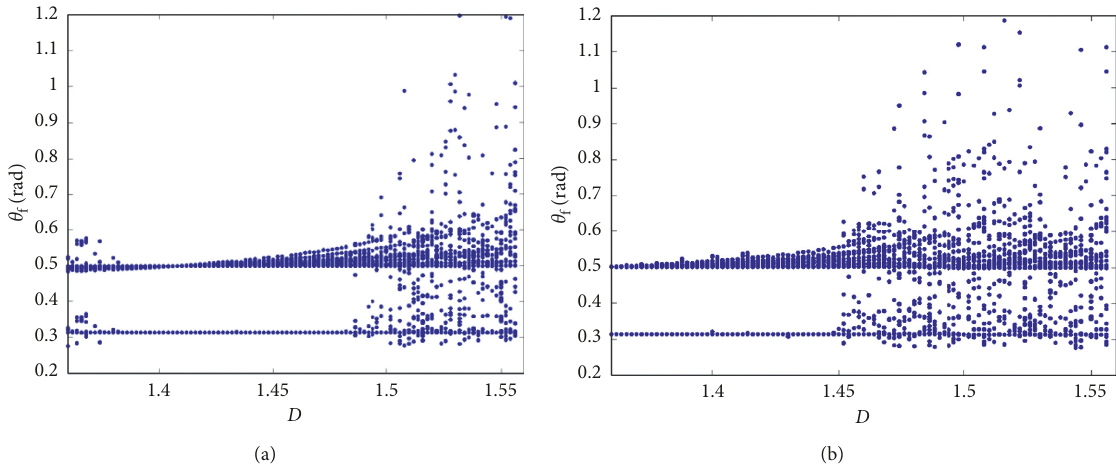
Figure 6: Global bifurcation diagram of θ